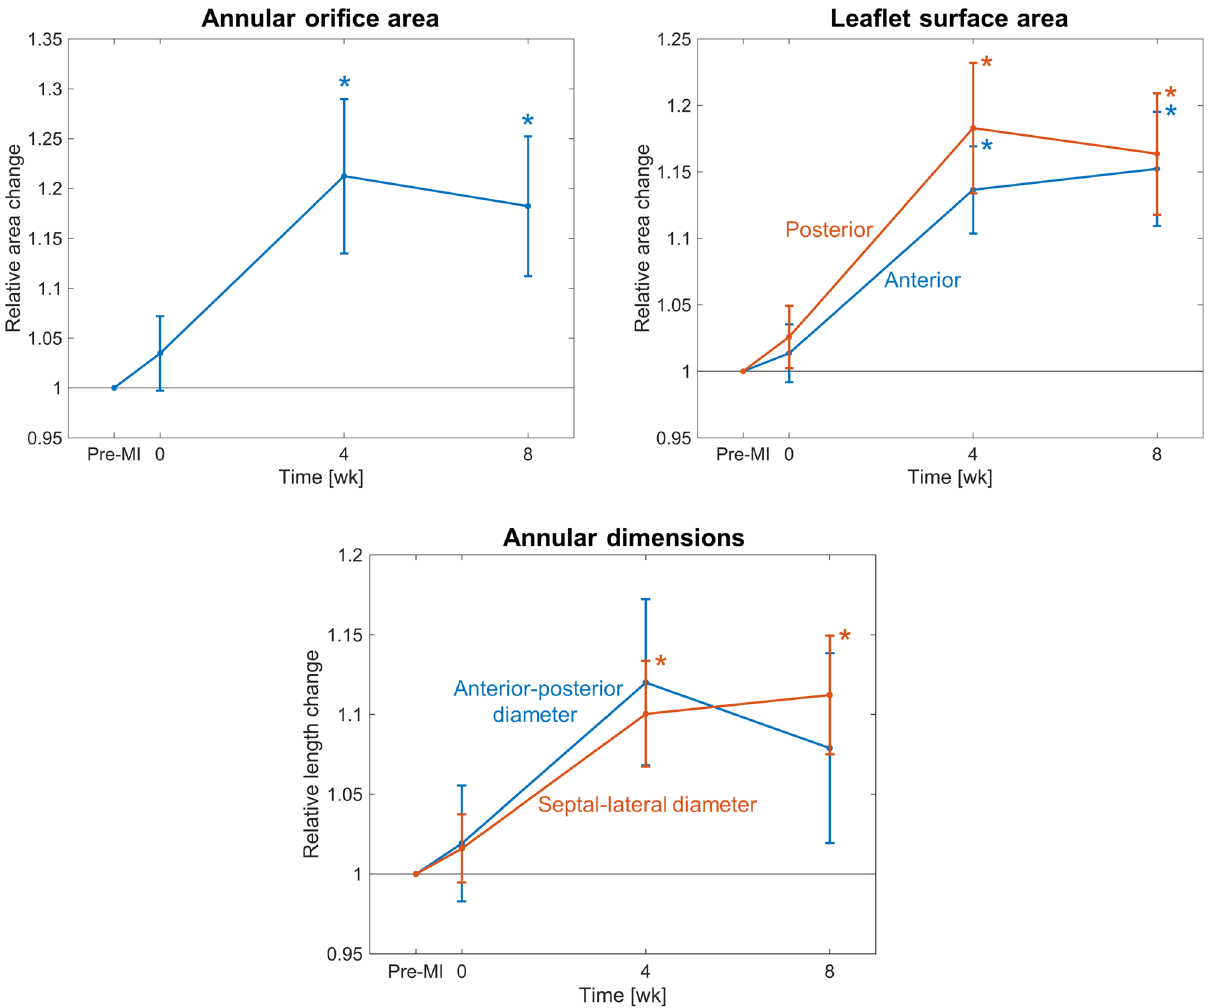
Figure 2. Changes in annular orifice area, the surface area of each leaflet, and annular dimensions over time, relative to their respective pre-MI values. Qualitatively, annular dilation and enlargement of both leaflets move in tandem, all increasing substantially within 4 weeks post-MI and apparently stabilising by 8 weeks configuration (see the pre-MI state in Fig. 1). Results of this analysis indicated substantial plastic stretches in both the circumferential and radial directions, with significant regional heterogeneity (Fig. 3). Moreover, these changes appeared to stabilise after 4 weeks, as evidenced by the similarities between the 4 and 8 week data (Fig. 3). We next examined the systolic stretch behaviours post-MI, which result exclusively from systolic loading. Based on the observations of time-evolving diastolic reference configurations, we utilized both the pre-MI and current diastolic reference configurations in our computations. When referenced to the pre-MI diastolic reference configuration , the directional stretches remained largely unchanged over much of the leaflet (Fig. 4a). Interestingly, when referenced to the current diastolic state , the magnitudes of the systolic stretches indicated a gradual diminution in magnitude over the 8 weeks time period (Fig. 4b). Post-MI changes in deformation also altered shear patterns in certain regions of the leaflet, significantly decreasing the magnitude of the shear angle experienced by the posterior leaflet commissural segments (P1, P3) in systole (Fig. 5). Next, to clarify these findings as regional trends, we computed the mean stretch values for each Carpentier leaflet segment (see "Methods" for details). When referenced to the pre-MI diastolic state, continued increases in diastolic circumferential stretches were observed in all posterior segments at 4 weeks, which generally stabilised thereafter (Fig. 6a). In contrast, the systolic stretches were compartively stable, with statistically significant but small in magnitude changes which again stabilised after 4 weeks (Fig. 6a). Similar trends were observed in the radial direction, with generally more pronounced changes in the diastolic configuration (Fig. 6b). In contrast, when the current diastolic referential configuration was utilized, the resulting systolic stretches indicated marked reductions in both the circumferential and radial directions, especially in the anterior leaflet (Fig. 7). Statistical analyses supported these findings (Table 1). Shear strain analyses generally revealed negligible changes in the A1, A2, and P2 segments (Fig. 8). In contrast, the P1 and P3 segments demonstrated gradual reductions in systolic